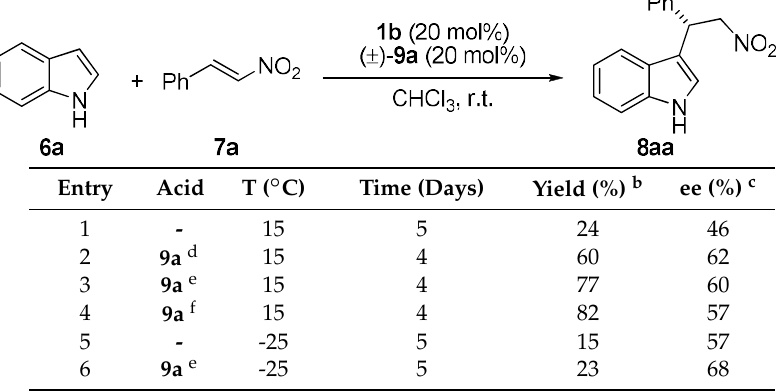
Table 2. Effect of temperature of model reaction. a